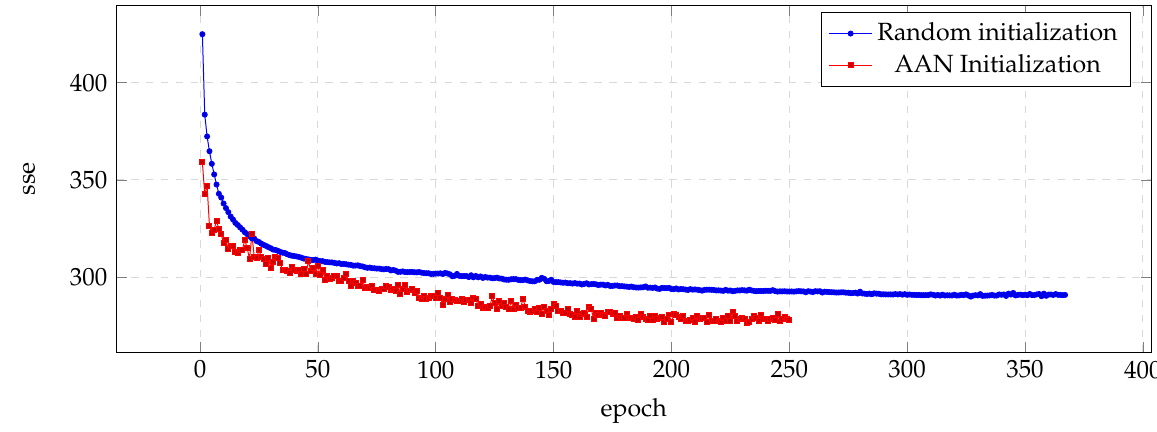
Figure 5. Evolution of the sse value for the validation set during the training process of the SLT voice.